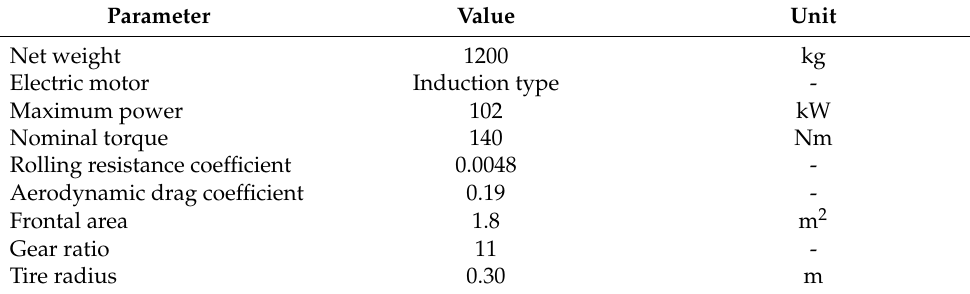
Table 1. FC test vehicle parameters.